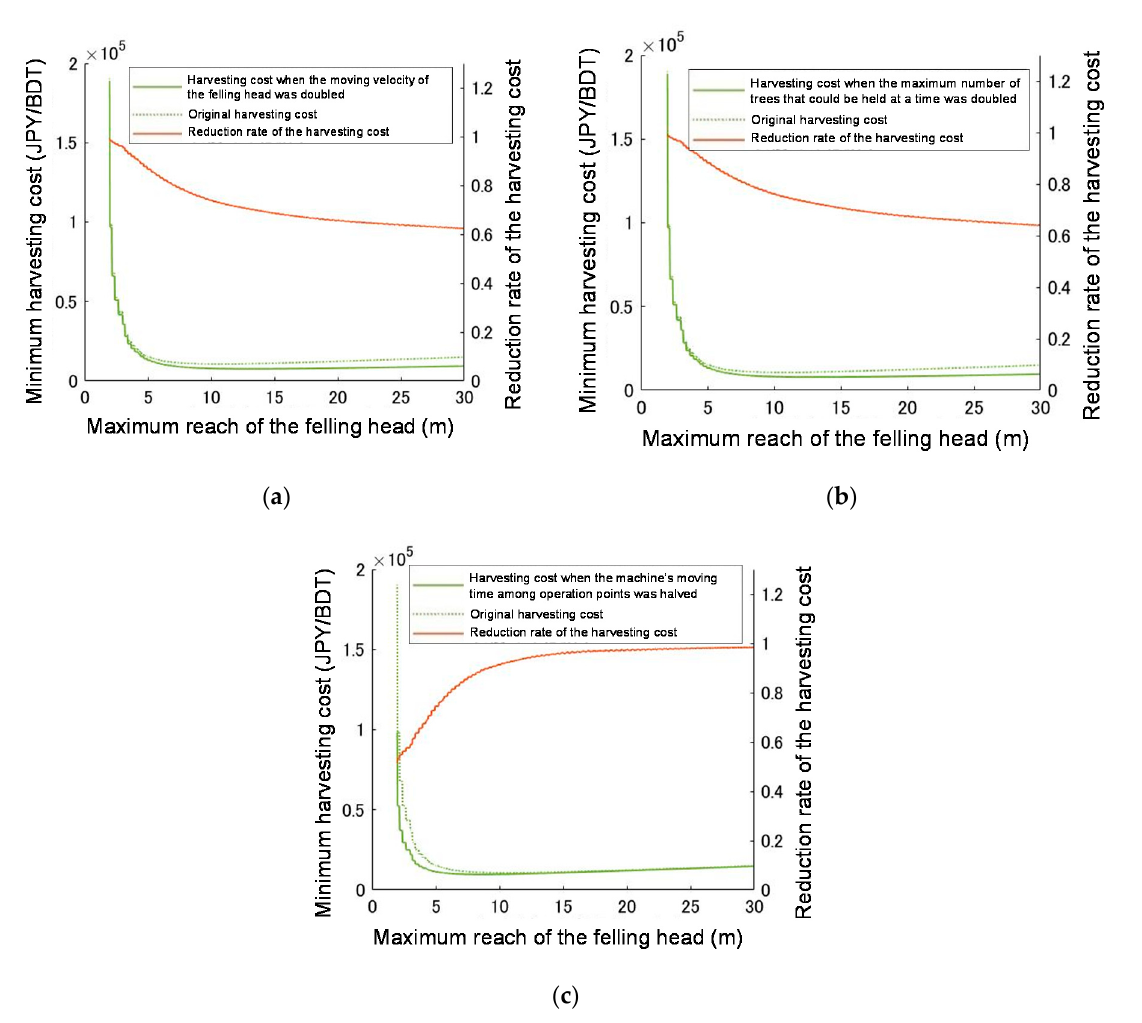
Figure 8. Results of the sensitivity analysis: ( a ) When the moving velocity of the felling head was doubled; ( b ) When the maximum number of trees that could be held at a time was doubled; ( c ) When the machine’s moving time among operation points was halved.